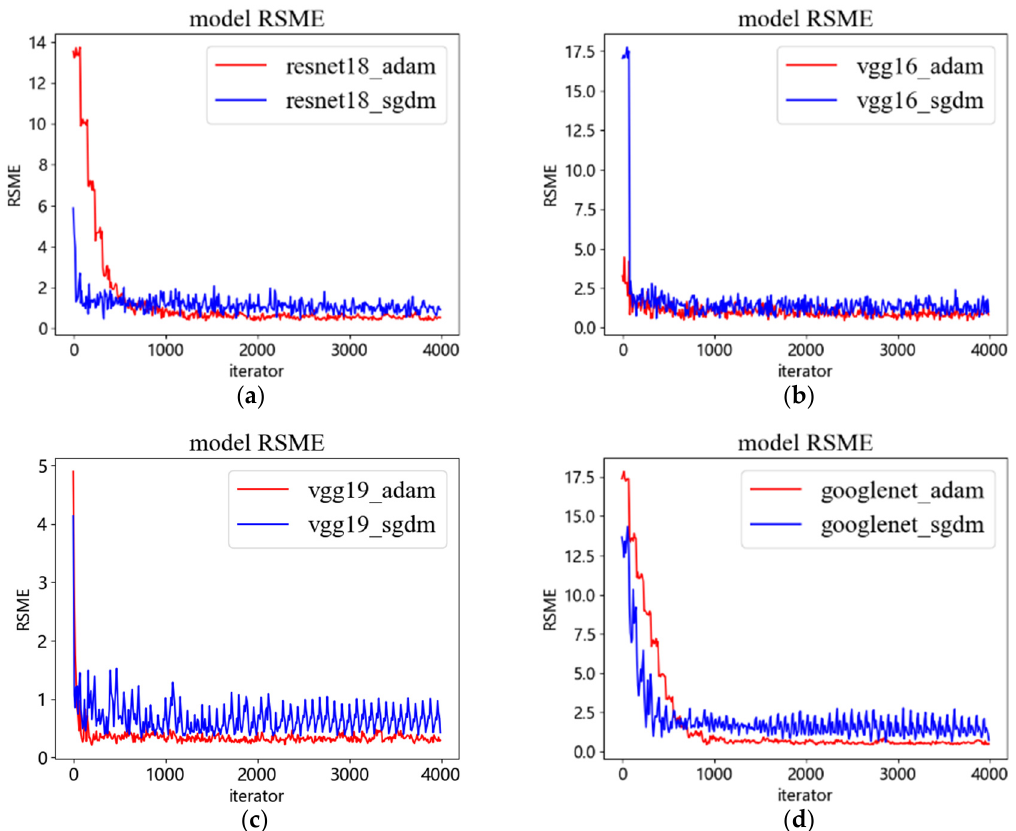
Figure 4. ( a ) Performance of the Resnet-18 model. ( b ) Performance of the VGG-16 model. ( c ) Performance of the VGG-19 model. ( d ) Performance of the GoogleNet model.